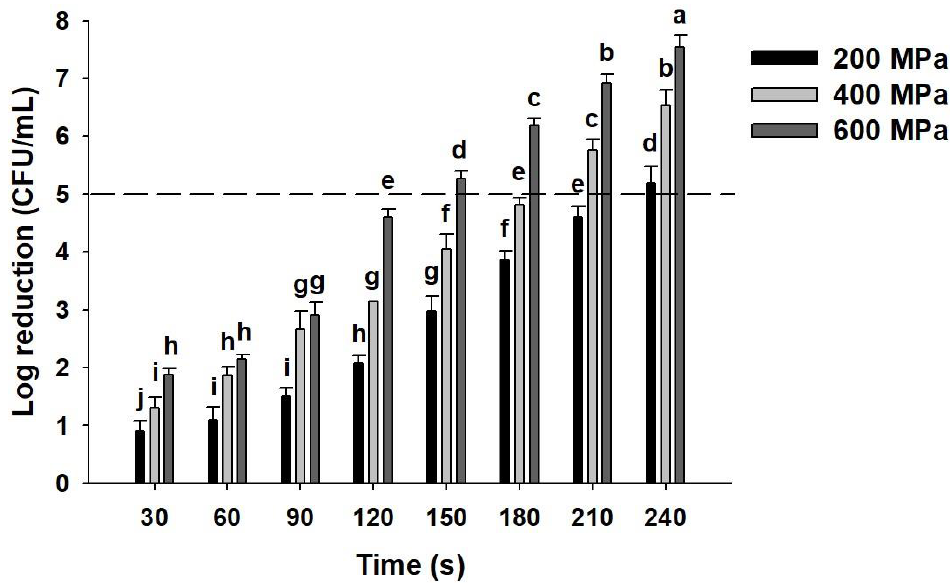
Figure 1. Effects of high-pressure processing on E. coli O157H7 in pigeon pea milk. Data are means of three determinations ± standard deviation ( n =3). Bars with different superscript letters are significantly different ( p < 0.05).